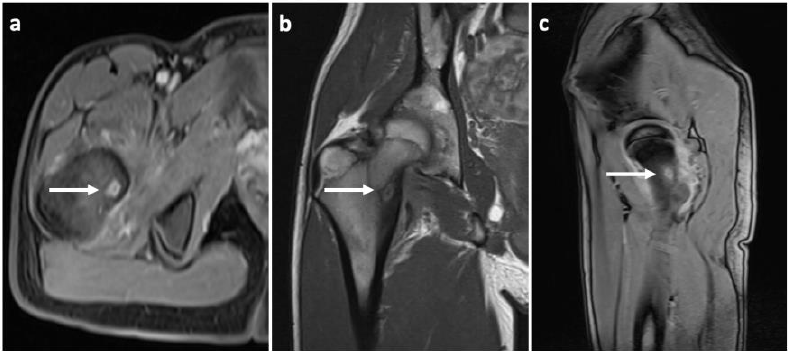
Figure 3. Different MRI (magnetic resonance imaging) views with white arrows indicating the location of the osteoid osteoma. ( a ) T1 vibe dixon transverse projection; ( b ) T1 TSE (turbo spin echo sequence) frontal projection; ( c ) T1 vibe dixon sagittal projection.